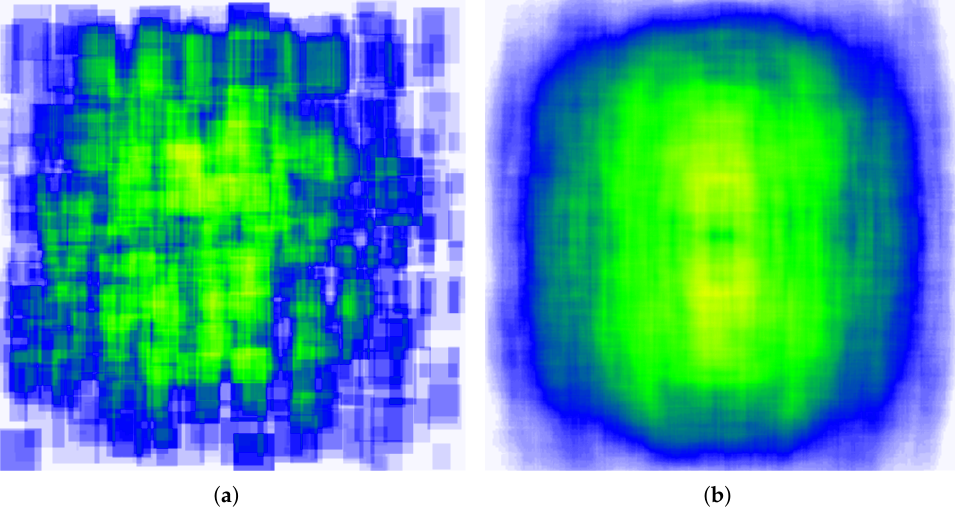
Figure 6. Annotation map of the location of the SMD component in the data set. Green and yellow represent higher density. ( a ) Annotation map of the initial dataset. ( b ) Annotation map of augmented